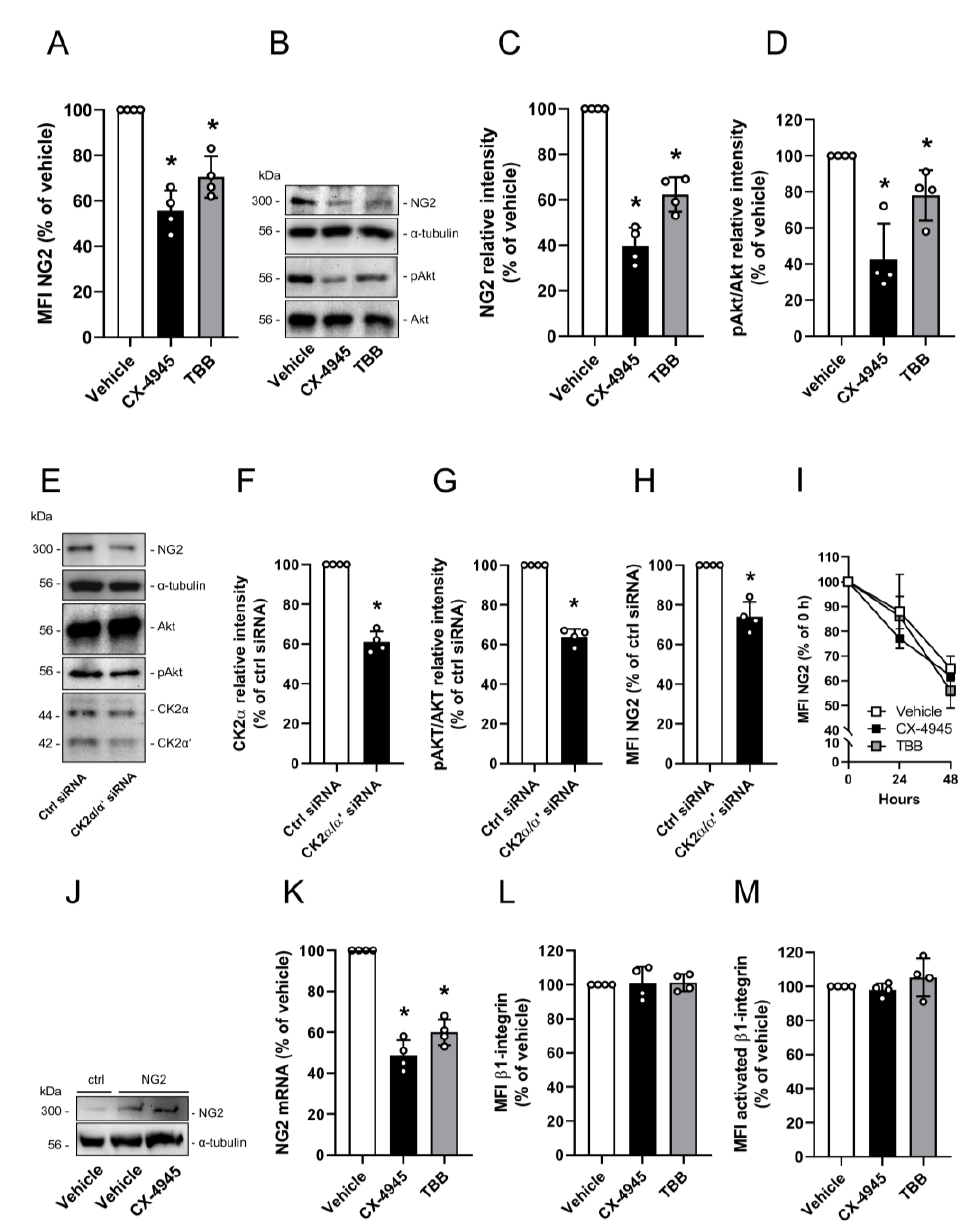
Figure 1. Effect of CK2 inhibition on NG2 expression. ( A ) Pericytes were treated with vehicle (DMSO), CX-4945 (10 µM) or TBB (50 µM) for 48 h. The cells were scratched and the mean fluorescence intensity (MFI) of NG2-positive cells was assessed by flow cytometry. Vehicle-treated cells were set 100%. Mean ± SD. * p < 0.05 versus vehicle ( n = 4). ( B – D ) Pericytes were treated as described in ( A ). The cells were lysed and the expression of NG2, Akt, pAkt and α -tubulin (as loading control) was analyzed by Western blot ( B ). NG2 / α -tubulin ( C ) and pAkt / Akt ( D ) were assessed by quantitative analysis of Western blots. Vehicle-treated cells were set at 100%. Mean ± SD. * p < 0.05 versus Vehicle ( n = 4). ( E – H ) Pericytes were treated with a combination of CK2 α and CK2 α ’ siRNA or with ctrl siRNA. The cells were lysed and the expression of NG2, Akt, pAkt, CK2 α , CK2 α ’ and α -tubulin (as loading control) was analyzed by Western blot ( E ). CK2 α / α -tubulin was assessed by quantitative analysis of Western blots ( F ). pAkt / Akt was assessed by quantitative analysis of Western blots ( G ). MFI of NG2-positive cells was detected by flow cytometry ( H ). ctrl siRNA-treated cells were set as 100%. Mean ± SD. * p < 0.05 versus ctrl siRNA ( n = 4). ( I ) Pericytes were treated with vehicle (DMSO), CX-4945 (10 µM) or TBB (50 µM) in the presence of Cycloheximide (CHX) for 0, 24 and 48 h. Then, the cells were scratched and the MFI of NG2-positive cells was assessed by flow cytometry. Cells at 0 h were set 100%. Mean